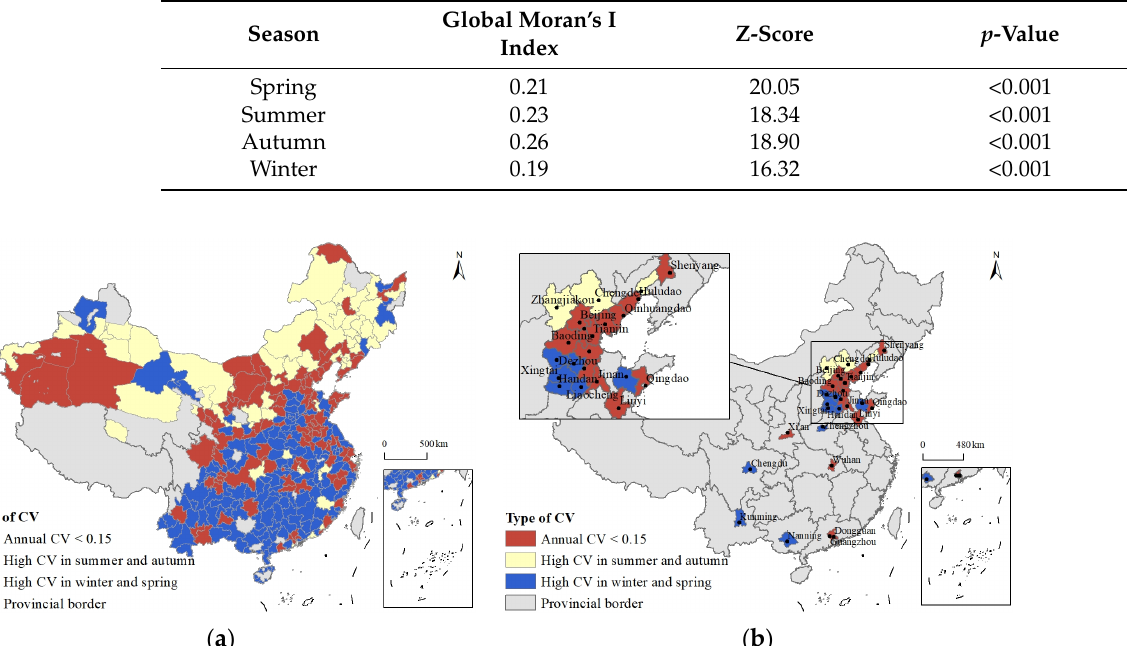
Figure 7. Spatial distribution of city coefficient of variation: ( a ) nationwide; ( b ) core